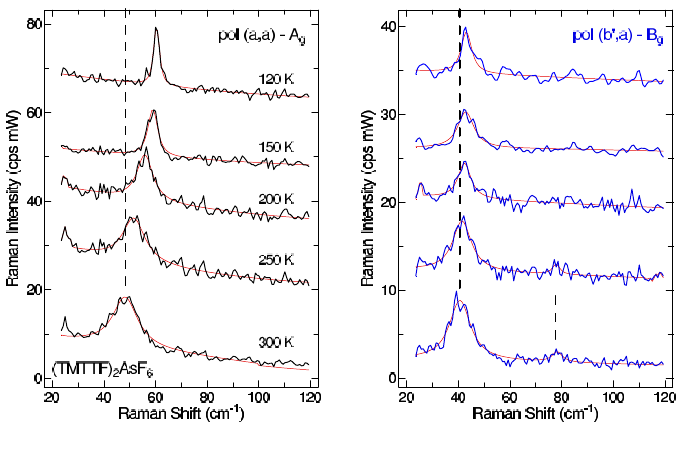
AsF in the polarization ( a, a ) and 2 6 ones. g